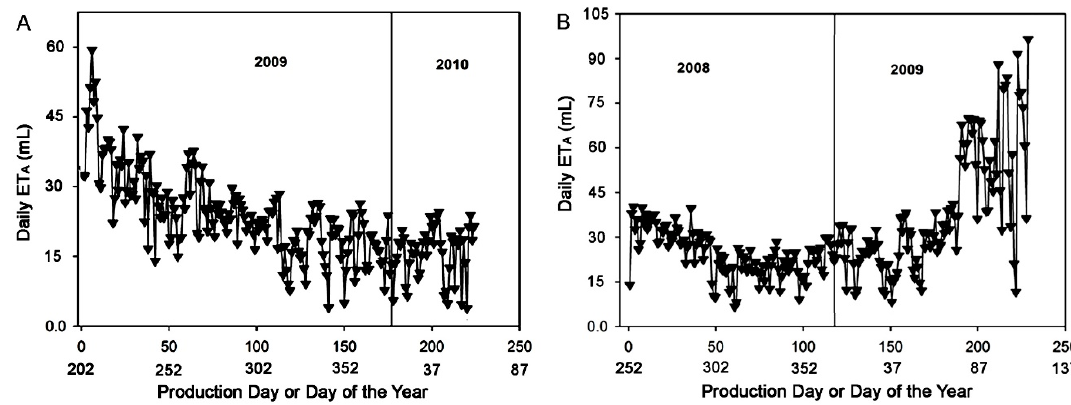
Figure 2. Mean daily actual evapotranspiration (ET A ) of Calathea ‘Silhouette’ ( A ) and Stromanthe sanguinea ( B ) grown in 15 cm containers during production from tissue-cultured liners to marketable sizes. Each triangle is the mean daily ET A of four plant replicates. The vertical line separates the year.